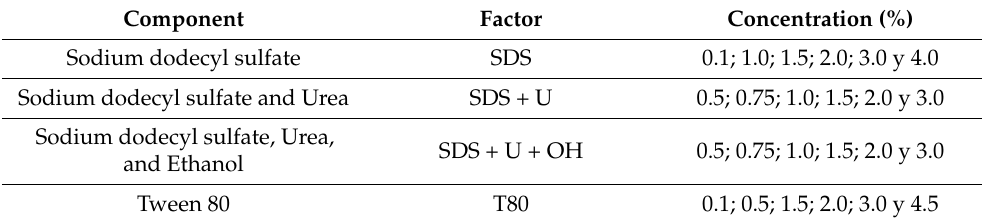
Table 3. Design of experiments to improve protein removal.